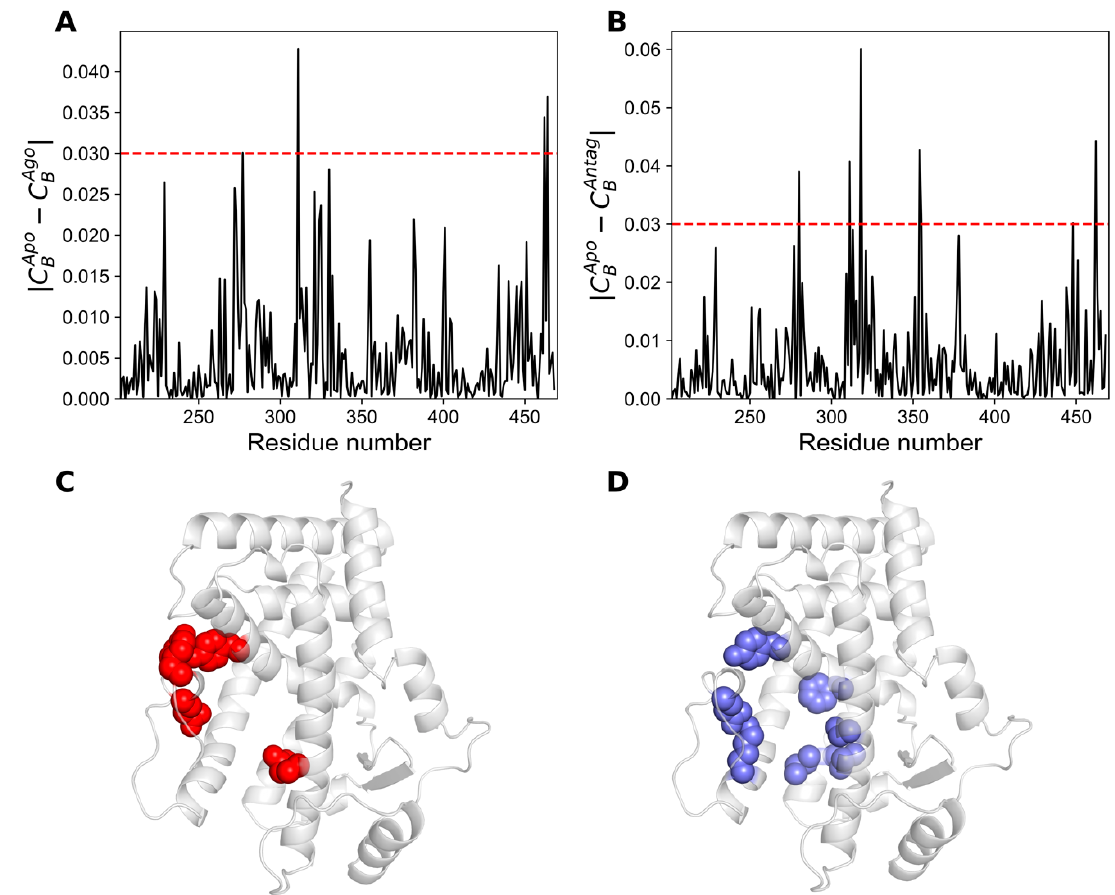
Figure 8. Difference of C B values calculated for ( A ) apo and agonist-bound structures. ( C ) Residues with | C BApo − C BAgo | ≥ 0.03 depicted on the apo minimized structure as red spheres, contributed mainly from the orthosteric pocket and C-terminal region; ( B ) difference of C B values calculated for apo and antagonist-bound structures; ( D ) similarly, residues with | C BApo − C BAntag | ≥ 0.03 depicted on the apo minimized structure as slate blue spheres, contributed primarily from the ligand binding pocket and C-terminal region.